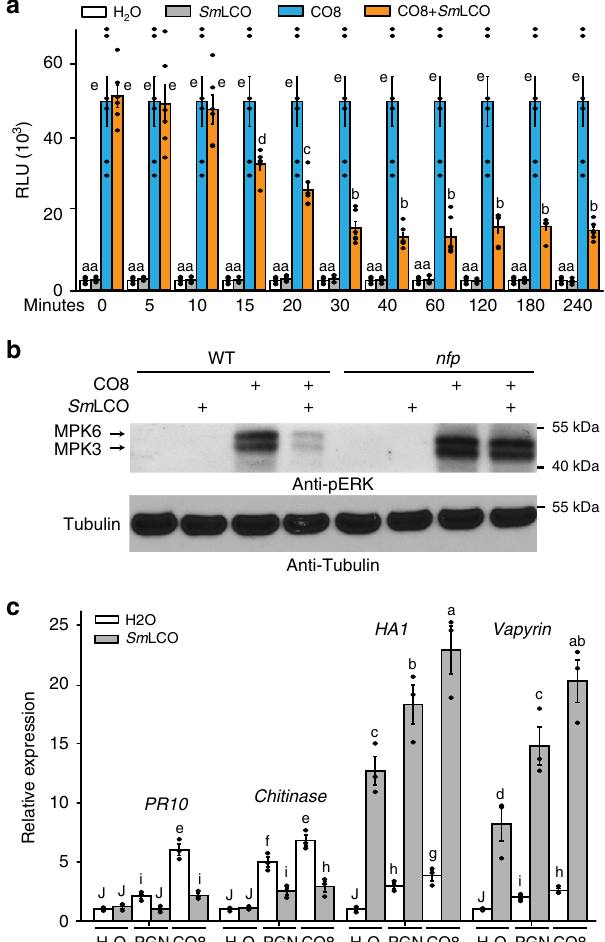
Fig. 5 A combination of CO8 and Sm LCO can promote symbiosis and inhibit immunity signalling. a M. truncatula wild-type roots were pretreated with 10 − 8 M Sm LCO for different time points (minutes) before incubation with 10 − 6 M CO8 for induction of ROS. The signi fi cant groupings were calculated with a Mann – Whitney Rank Sum Test (mean ± s.e.m., n = 6; P < 0.05). This experiment was repeated twice with similar results. b MAPK activation in wild type and nfp roots induced by 10 − 6 M CO8 with or without 30 min pretreatment of 10 − 8 M Sm LCO. c Equivalent treatment as b for qRT-PCR detection of gene expression testing immunity reporters PR10 and a Chitinase and symbiosis reporters HA1 and Vapyrin in response to CO8 and PGN, with or without Sm LCO. Relative fold change compared to individual water treatments are shown. Letters denote statistically signi fi cant groupings calculated with Mann – Whitney Rank Sum Test (mean ± s.e.m., n = 3; P < 0.05), this experiment was repeated twice with